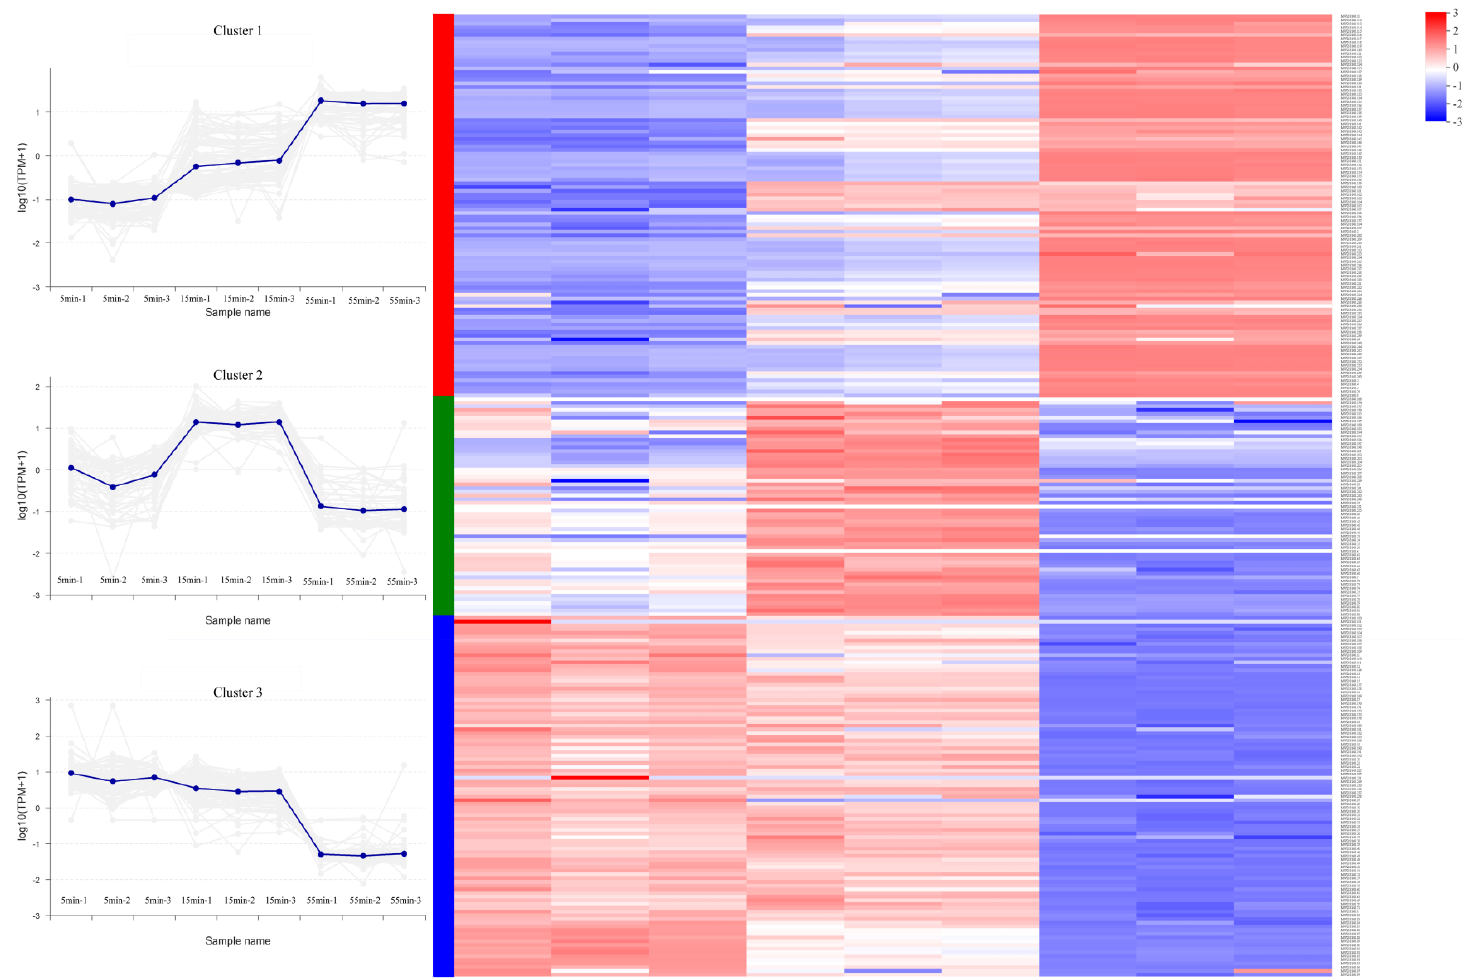
Figure 2. Transcriptomic profile of SA1 genes in the host S. lentus JTB1-3. Cluster analysis was performed using the online tool of Majorbio Cloud Platform (https://cloud.majorbio.com/page/tools/, accessed on 30 March 2022) to cluster a total of 259 genes (2 to 260) based on their TPM values and K-means method. Cluster 1: late genes. Cluster 2: middle genes. Cluster 3: early